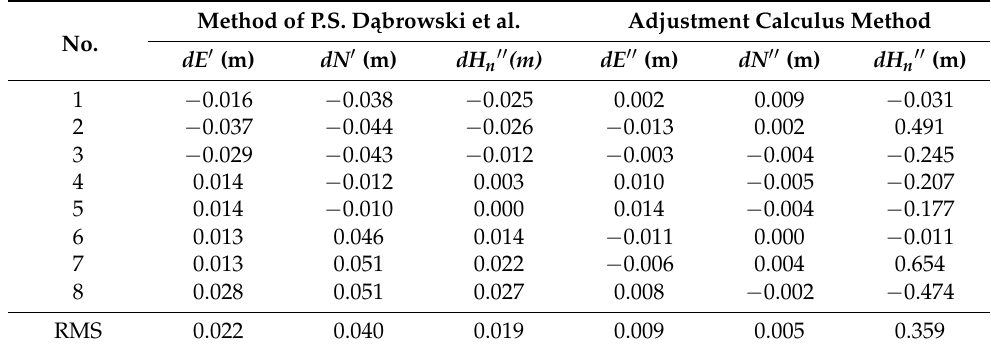
Table 13. Absolute error values of the measurement point coordinates determined by the method of P.S. D ˛abrowski et al. and the adjustment calculus